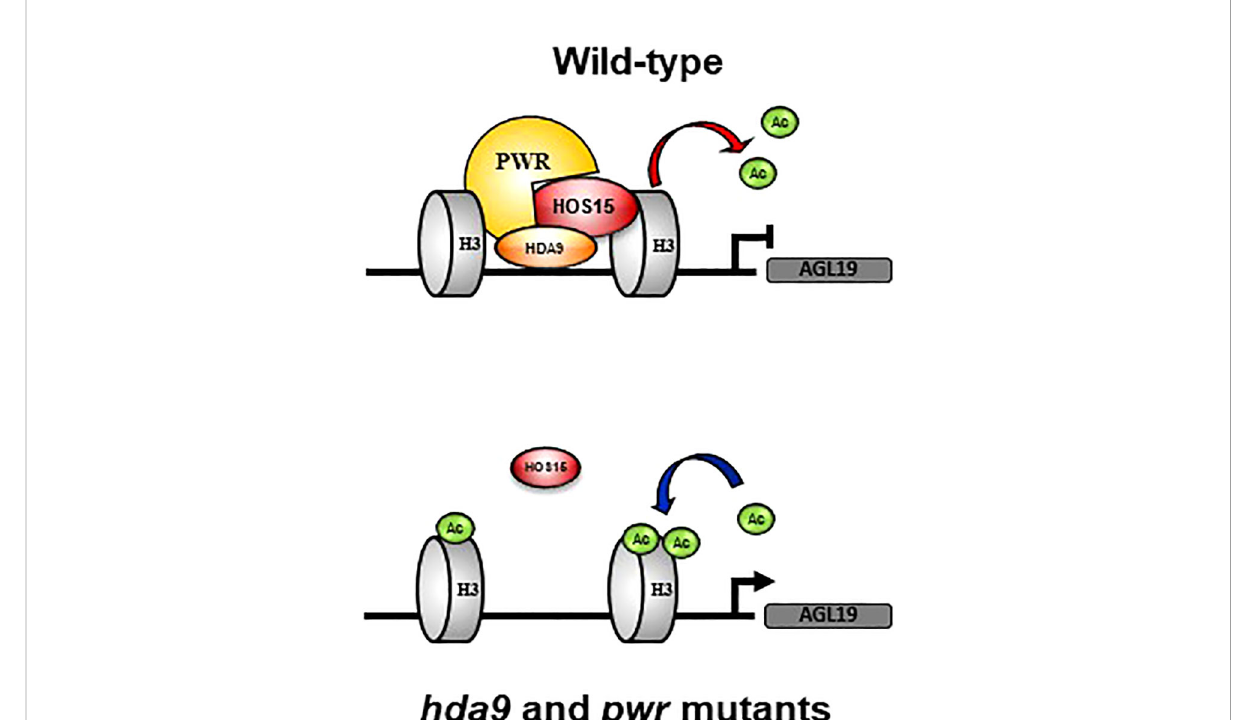
FIGURE 6 Working model for HOS15-PWR-HDA9 complex in fl owering. Under natural conditions (wild-type), the HOS15-PWR-HDA9 complex negatively regulates AGL19 gene expression through histone deacetylation. In the absence of PWR and HDA9, which interact with HOS15 to form a complex, the accumulation of HOS15 in the nucleus is reduced. Disruption of the HOS15-PWR-HDA9 repressor complex results in enhanced histone acetylation and relaxed chromatin. AGL19 gene expression increases compared to that in the wild type, and fl owering is